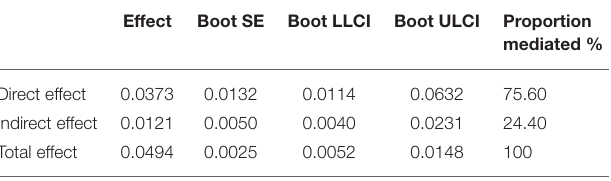
TABLE 3 | The mediation effect of anxiety symptoms between childhood maltreatment and SA.